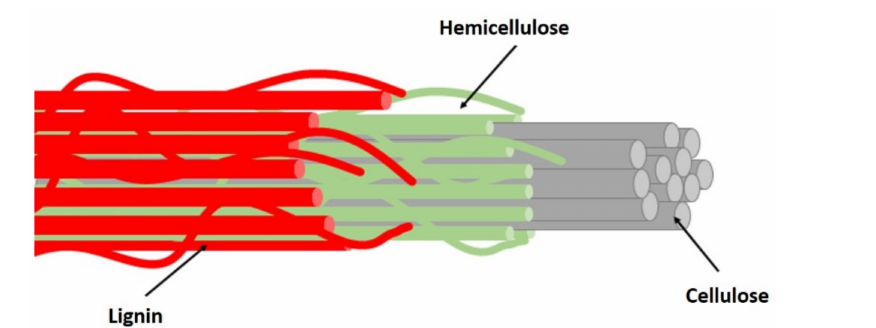
Figure 1. Schematic representations of natural fibers.